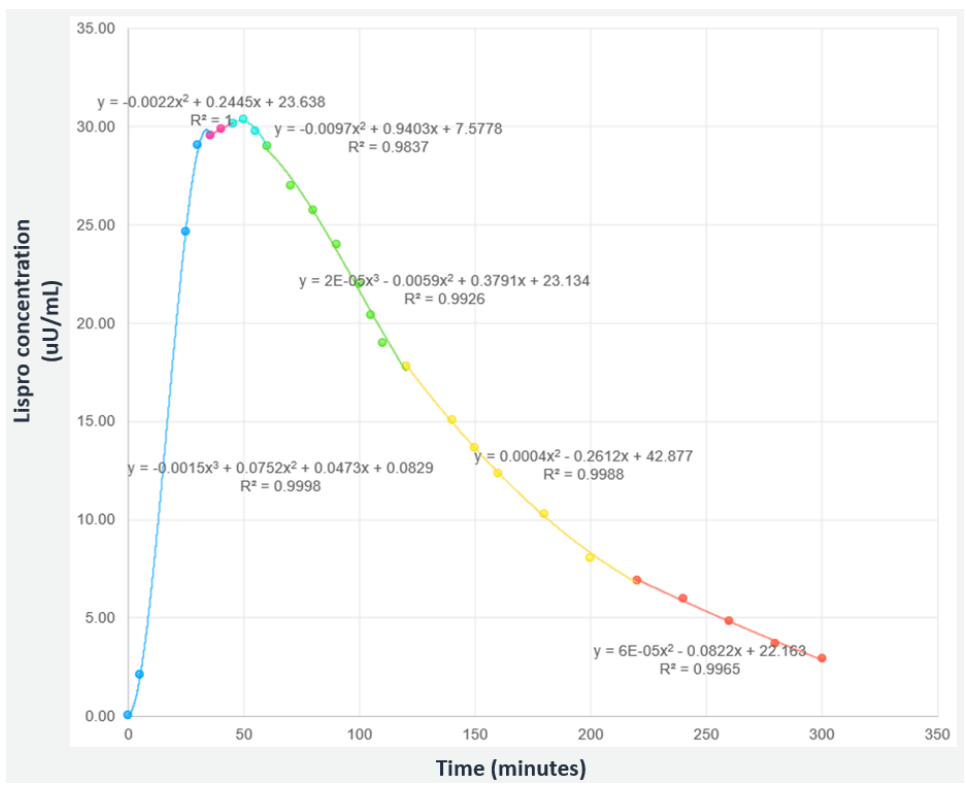
Figure 2. The piecewise polynomial for Lispro insulin (fast-acting) considering 0.16 U/kg